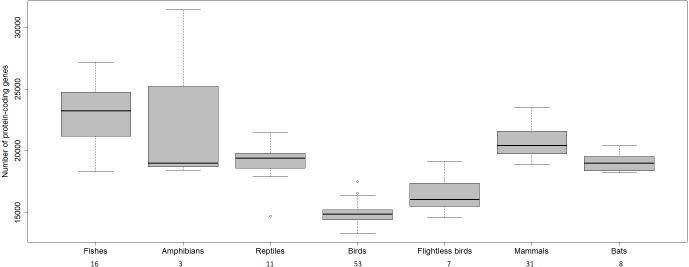
Number of protein-coding genes estimated for different vertebrates.The numbers below refer to the number of species used to construct the figure. Data source: www.ncbi.nlm.nih.gov/genome (O’Leary Nuala et al., 2016); www.ensembl.org/info/about/species.html ( Zerbino et al., 2018).